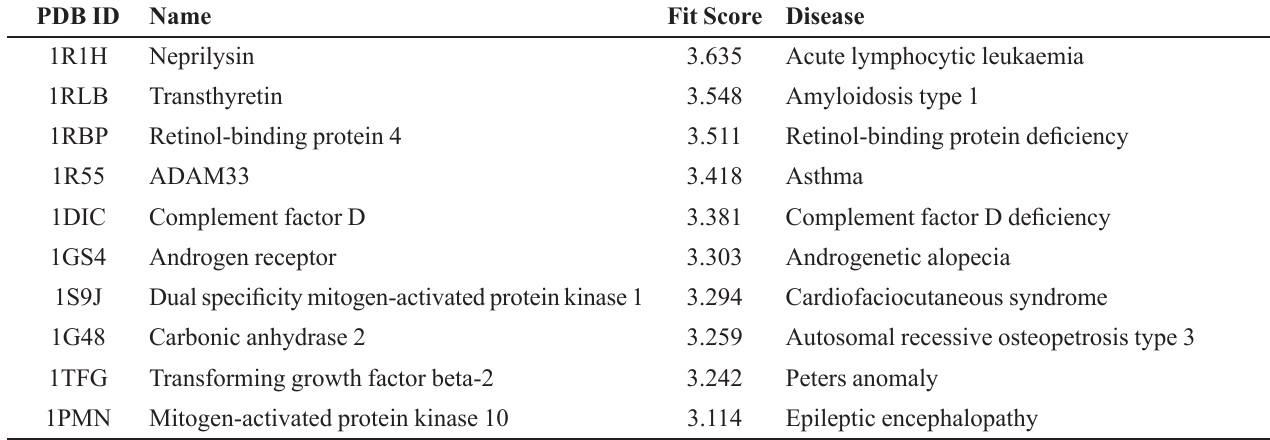
TABLE I - Top ten potential disease-related targets of arteannuin predicted by PharmMapper PDB ID